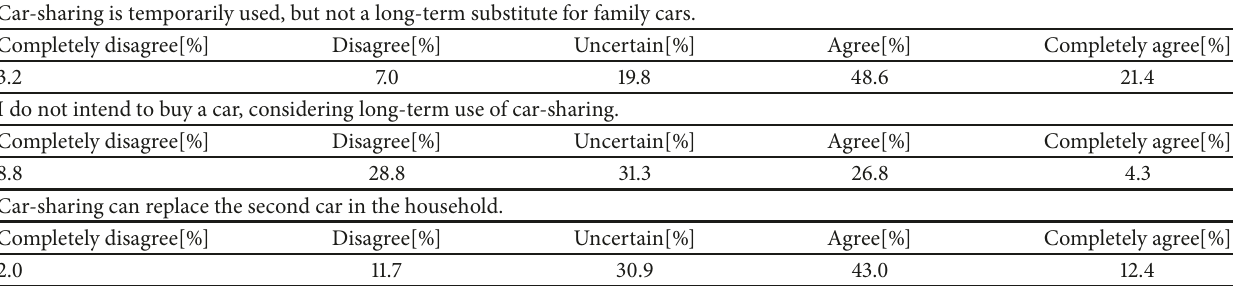
Table 7: Responses to attitudinal questions.